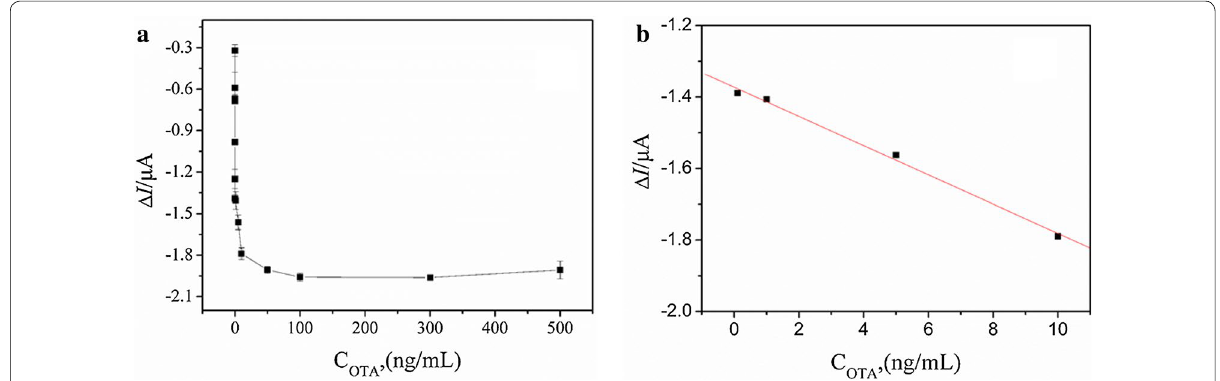
Fig. 6 a The dependence of ΔI on increasing OTA concentrations. b The linear relationship between ΔI and OTA concentrations